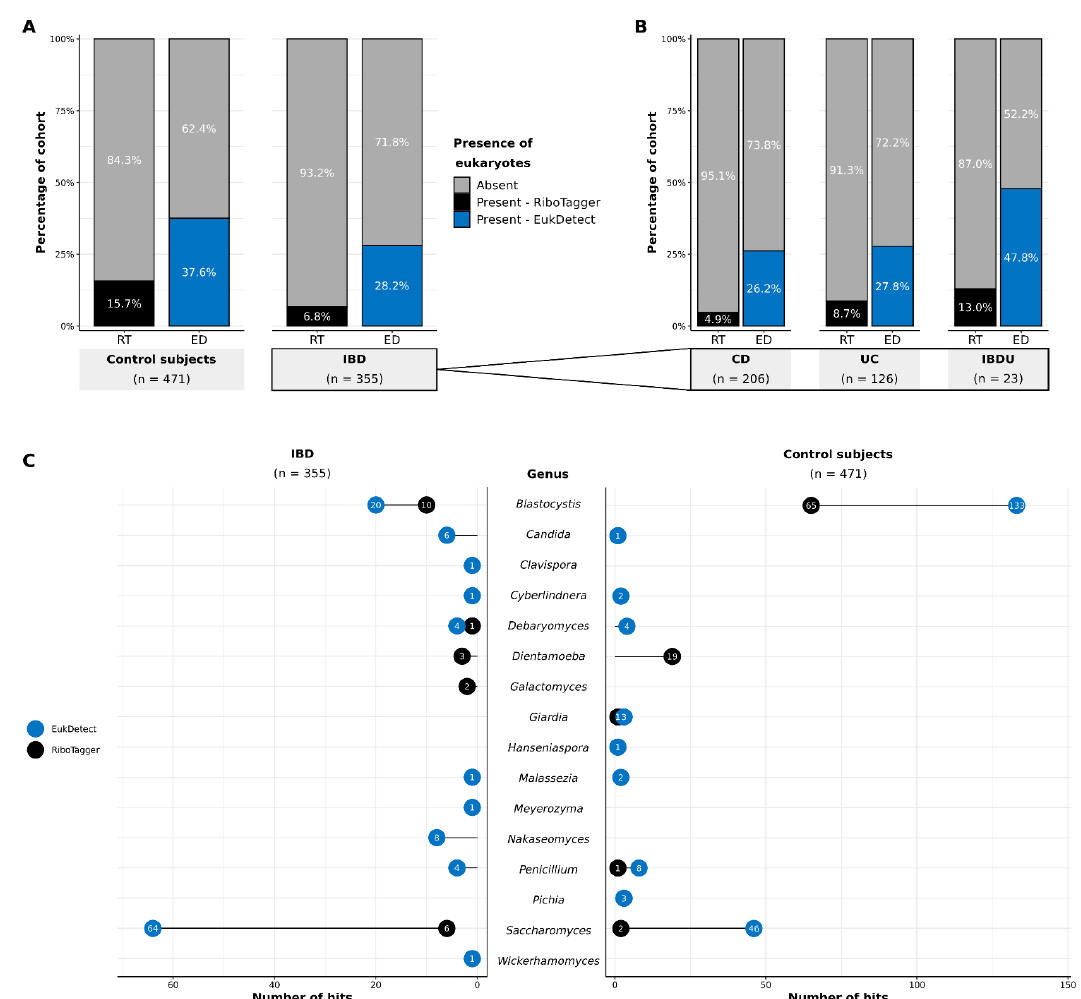
Figure 1. Prevalence of microbial eukaryotes in shotgun stool metagenomes of people with inflammatory bowel disease (IBD) ( n = 355) and unaffected individuals (control subjects) ( n = 471). ( A ) The proportion of individuals with microbial eukaryotes in their sample with at least family-level resolution is shown according to results detected by RiboTagger (RT) and EukDetect (ED) in control subject and IBD cohorts; ( B ) The same results are displayed as a proportion of samples with microbial eukaryotes detected in individuals with their IBD subtype—Crohn’s disease (CD) ( n = 206), ulcerative colitis (UC) ( n = 126), and IBD unclassified (IBDU) ( n = 23)—of the total IBD cohort; ( C ) The detection of microbial eukaryotes with at least genus-level resolution by RiboTagger and EukDetect in people with IBD and control subjects. A hit represents a single taxon identified in one sample. Individuals in all groups had only one sample per individual. Results are based on unrarefied sequencing data.